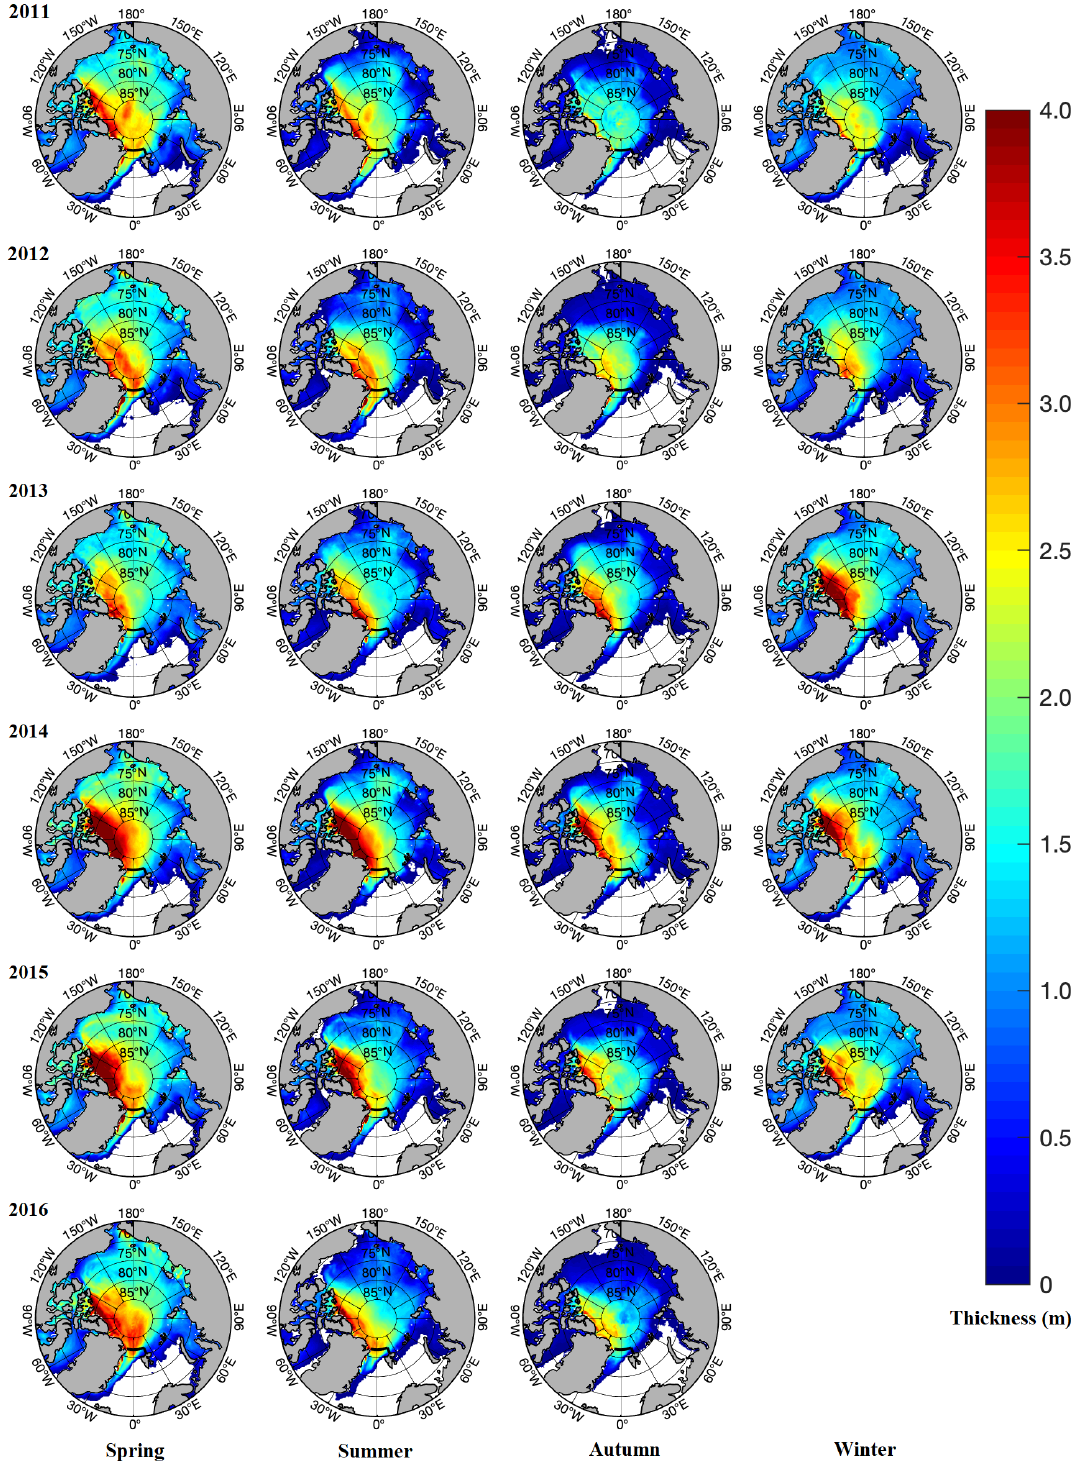
Figure 3. Seasonal variation in Arctic sea ice thickness. The thick black line represents the sea ice flux gate in the Fram Strait used in this